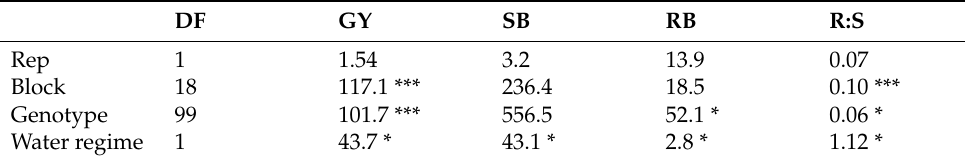
Table 4. Mean squares after combined analysis of variance for phenotypic traits of 100 wheat genotypes evaluated across the two water regimes and the two environments (field and glasshouse).